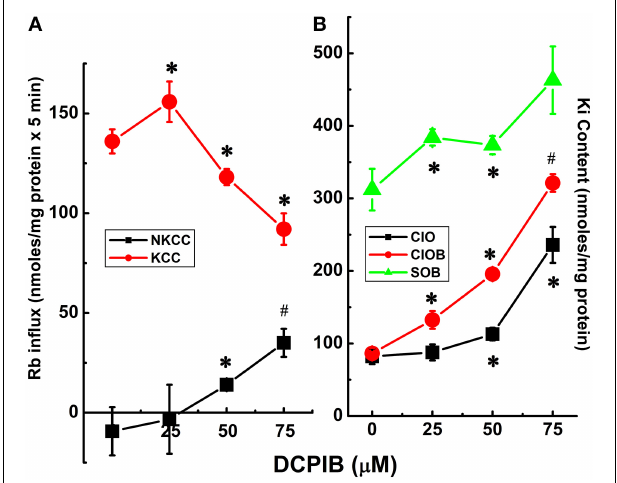
FIGURE 8 | Cl-dependent Rb + influx and K i content in constitutively dephosphorylated KCC3 cells are DCPIB-sensitive. Lines indicate doxycycline-induced Rb + influx (A) and K i content (B) , which were assessed in the following media: Cl − + 0.1mM ouabain (ClO), Cl − + (ouabain + 10 µ M bumetanide) (ClOB), S + (ouabain + bumetanide) (SOB) after induction of KCC3 T991A/T1048A (AA) (see Materials and Methods for details). (A) Calculated Rb + flux through NKCC, black squares and KCC, red circles as the Cl-dependent, ouabain-insensitive, bumetanide-sensitive Rb + influx, and Cl-dependent, ouabain and bumetanide-insensitive Rb + influx, respectively. Calculation of NKCC in AA cells after induction may result in a negative or positive value depending on the relative magnitude of the Rb + influx in ClOB with respect to ClO, i.e., CLO − CLOB = + or − NKCC (A) ; for K i content (B) ClO, black squares, CLOB, red circles and SOB, green triangles (see Results and Discussion for further details). Flux time, 5min; n = 4 individual determinations. * p < 0 . 05 and # p < 0 . 005 as determined by paired t -test with respect to 0 µ M DCPIB; data represent the mean ± SEM values. Representative results from 4 similar